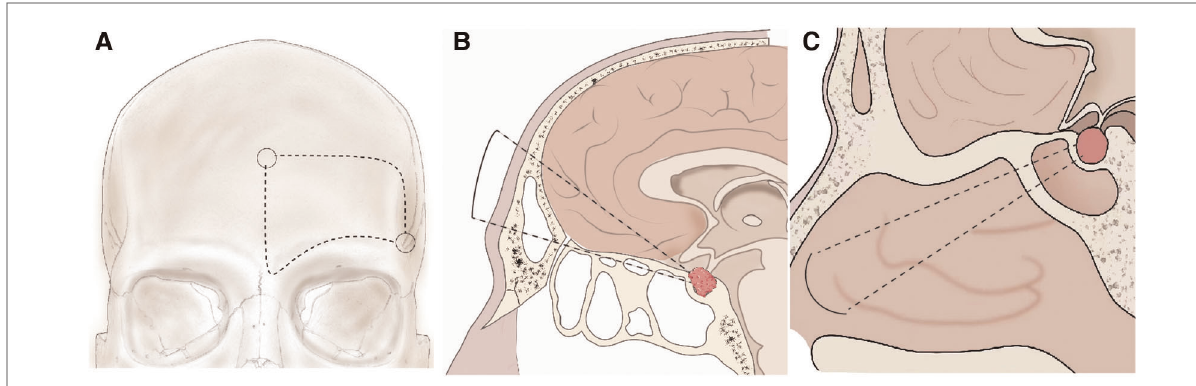
FIGURE 1 Schema of the unilateral subfrontal approach and ETSA. ( A ) The bone fl ap using in the unilateral subfrontal approach. One key burr hole (arrow) was placed behind the frontozygomatic process and below the superior temporal line. The other was placed in the midline above the nasion. ( B ) After unilateral subfrontal craniotomy, extradural dissection was performed in the central portion of the anterior cranial fossa around the cribriform plate. Elevation of the subfrontal dura from the planum sphenoidale can access tumor extension superior to the suprasellar region. ( C ) After drilling the bone of the sella, planum sphenoidale, and the tuberculum sellae, the dura was exposed and coagulated. The tumor in the sellar and suprasellar can be removed under endoscopic